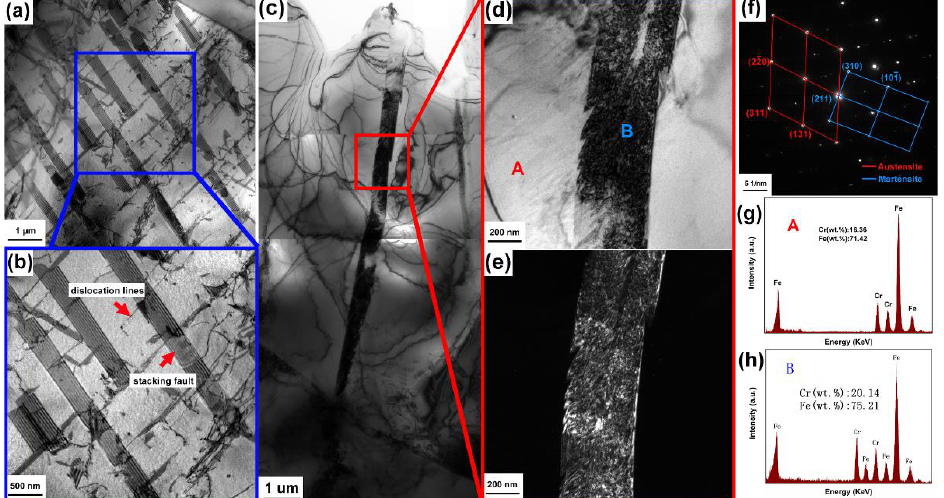
Figure 4. TEM images of ( a ) HR-MASS, and ( b ) shows the magnified image of the area marked by blue box in ( a ). ( c ) shows the deformation induced martensite (DIM) in austenite grain of HR-MASS, ( d , e ) is the magnified bright-field and dark-field images of the area marked red frame in ( c ), respec- tively. ( f ) is the corresponding selected-area diffraction pattern of ( e ). ( g , h ) show the chemical com- position of steel substrate (point A in ( d )) and DIM (point B in ( d )) for HR-MASS. In addition, several black round particles with 50 – 100 nm in diameter are located near the dislocation lines or slip bands. According to the indexing results of their selected area diffraction pattern (SEDP, Figure 3d), the d-values of the three directions are calcu- 36.3°, respectively. The lattice parameter of the particles was then calculated as 1.05 nm.